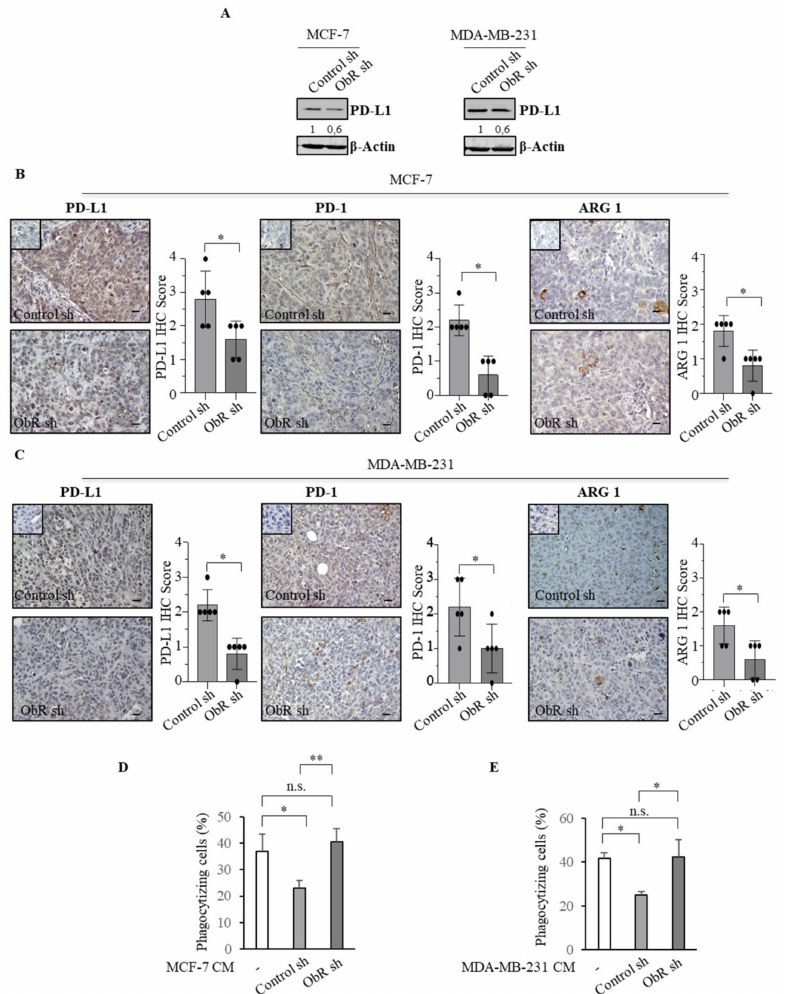
Figure 7. E ff ects of the lack of ObR on the tumor immune microenvironment. ( A ) Immunoblotting showing programmed death ligand 1 (PD-L1) protein expression in Control sh and ObR sh MCF-7 and MDA-MB-231 breast cancer cells. β -Actin was used as a control for equal loading and transfer. Italicized numbers below blots represent the mean of the band optical density expressed as fold over Control sh ObR cells. PD-L1, programmed cell death protein (PD-1) and arginase (ARG 1) immunohistochemical staining and relative score of Control sh and ObR sh MCF-7 ( B ) and MDA-MB-231 ( C ) xenograft tumor sections. Inset, negative control. Scale bar = 25 µ m. THP-1 cells were stimulated with phorbol 12-myristate 13-acetate (PMA, 100 nM) for 14 h followed by 24 h rest to obtain THP-1 macrophage-like cells (M0). Phagocytic activity of M0 treated with 5% charcoal stripped media (-) or incubated with conditioned media (CM) derived from control sh and ObR sh MCF-7 breast cancer cells for 5 days ( D ) and MDA-MB-231 for 3 days ( E ). Cells were incubated with latex beads conjugated with FITC-IgG for 2 h. Pixel intensity of FITC labeled beads was normalized to number of cells and results